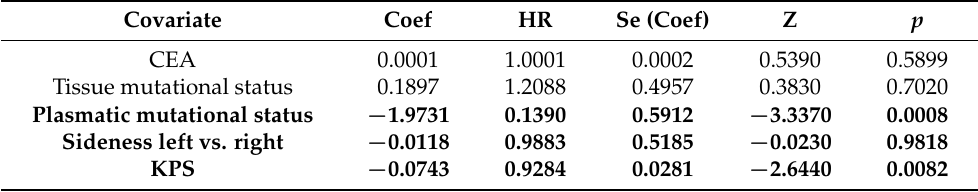
Table 2. Multivariate Cox-regression analysis for PFS. In bold variables with independent prognostic value are reported. Coef: beta coefficient, HR: hazard ratio, Se: standard error, Z: z-statistic. Covariate Coef HR Se (Coef) Z p